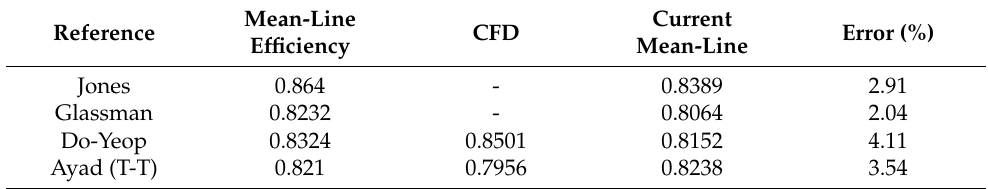
Table 3. Comparison between the T-S efficiency (except Ayad used T-T) calculated by the proposed mean-line and the reference